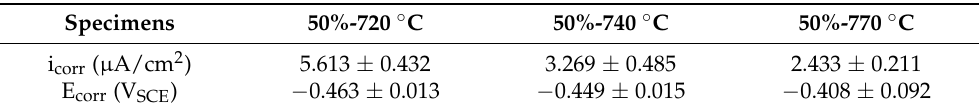
Table 4. i corr , E corr values of specimens at 90% deformation with different annealing temperatures derived from the potentiodynamic curves.